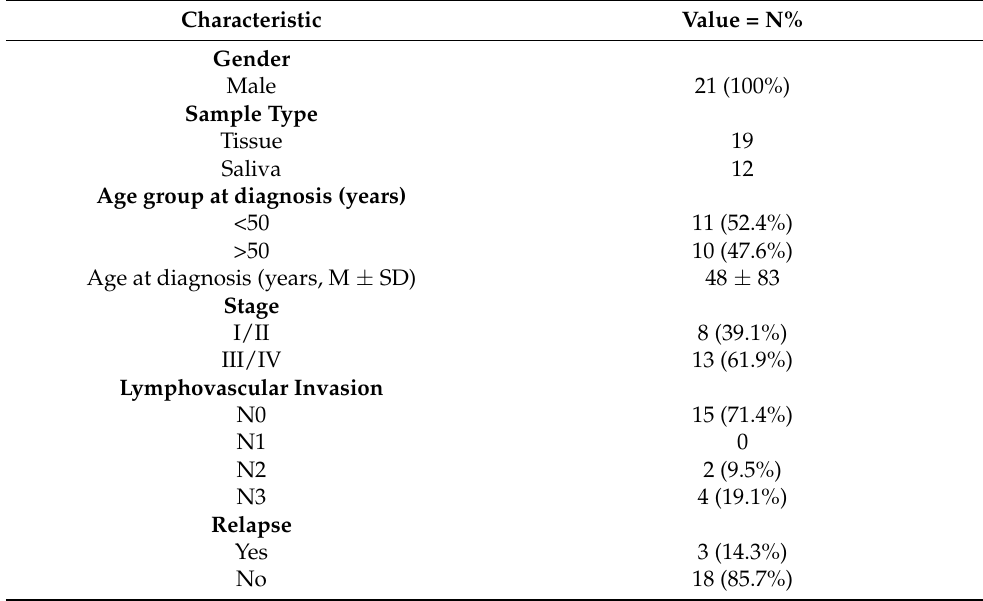
Table 2. Clinicopathological characteristics of OSCC patients included in the validation